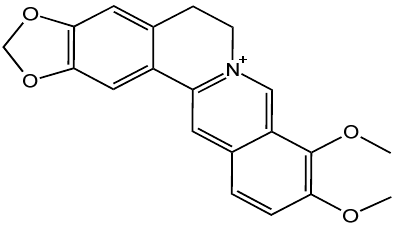
Figure 1. confirmed Chemical structure of BBR. Figure 1. Confirmed Chemical structure of